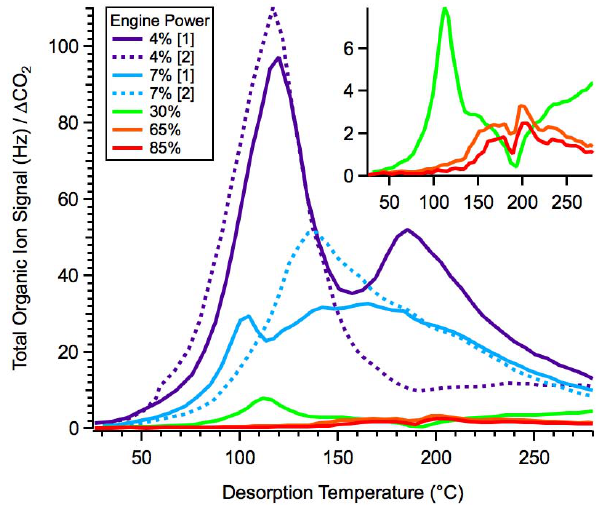
Fig. 5. Desorption profiles of total organic signal, divided by CO 2 enhancement to account for dilution, for each engine power condi- tion. Inset shows the desorption profiles for engine powers ≥